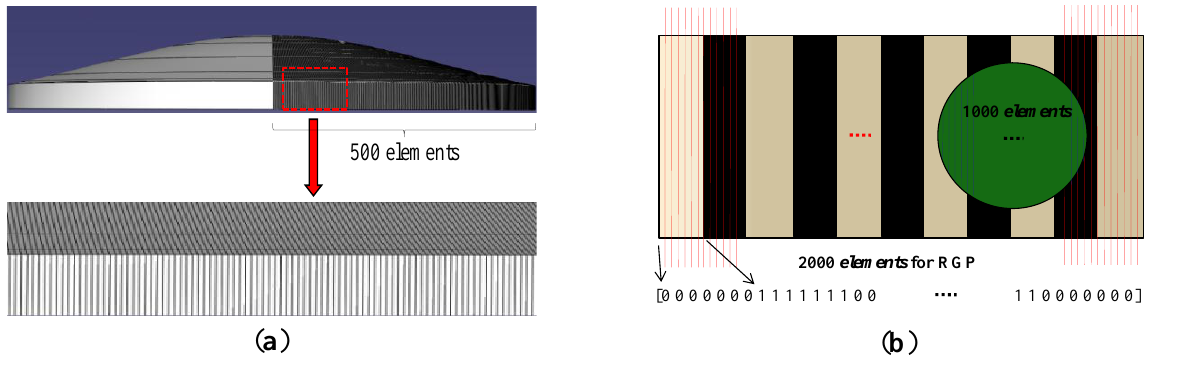
Figure 3. Schematic models for simulation. ( a ) Meshing using commercial software, ABAQUS 6.7; ( b ) Model of the RGP contains multibar and